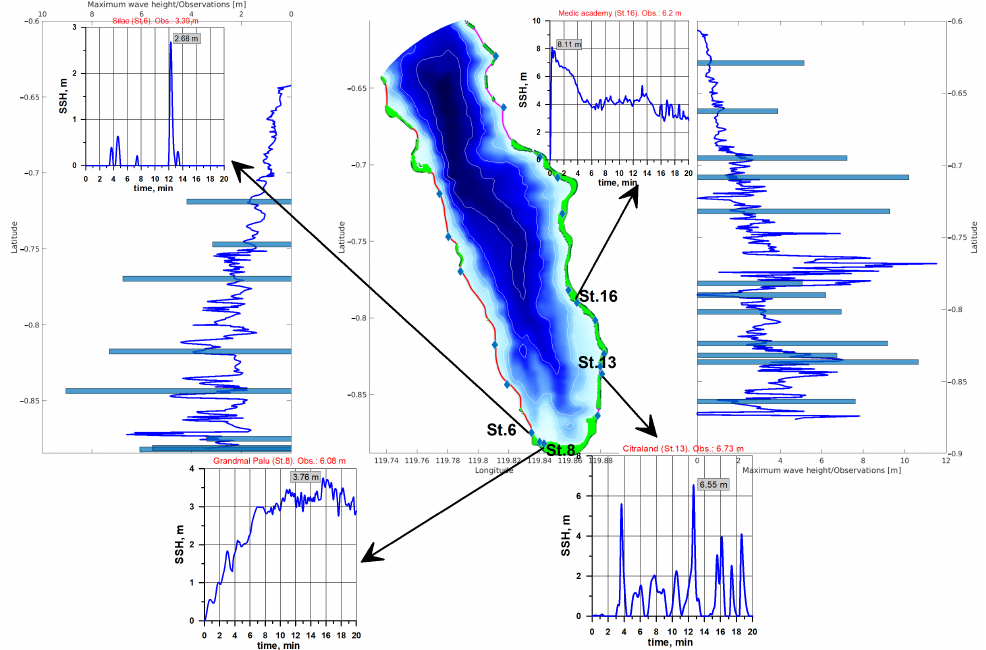
Figure 6. Comparison of the maximum wave height in the BE-3 experiment with observations [46]. The central panel shows the bathymetry of the simulated area and the observation stations. The flood zone in model calculations is highlighted in green. On the left and right (west and east coast) charts, the solid blue line shows the maximum wave height in the inundation area. The light blue bars